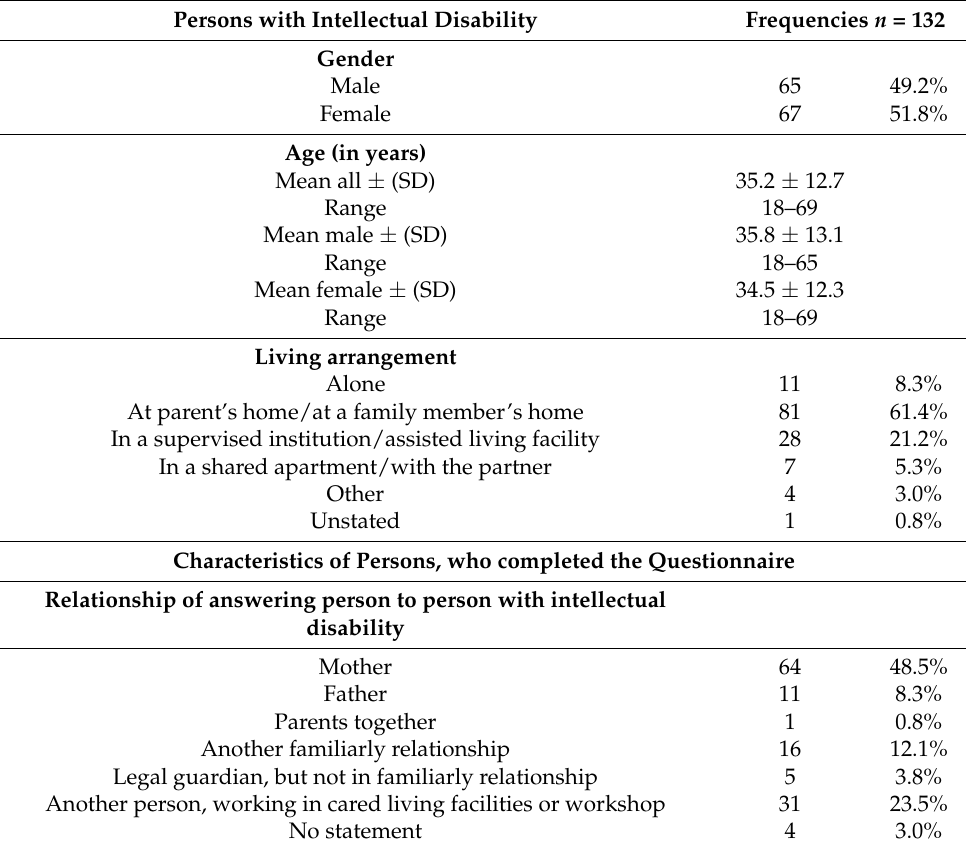
Table 1. Age, gender and living arrangements of the study participants, as well as information on the persons who completed the